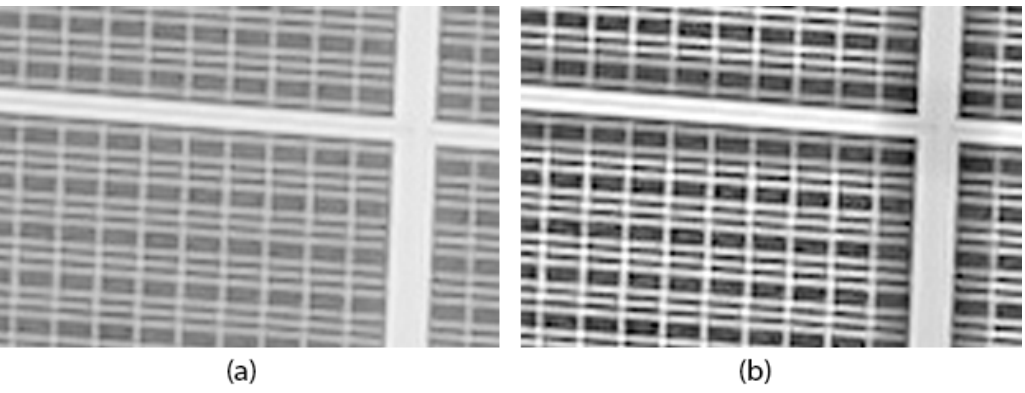
Figure 4. Image preprocessing filters: ( a ) contrast preserving decolorization algorithm; and ( b ) Wallis local contrast enhancement algorithm.